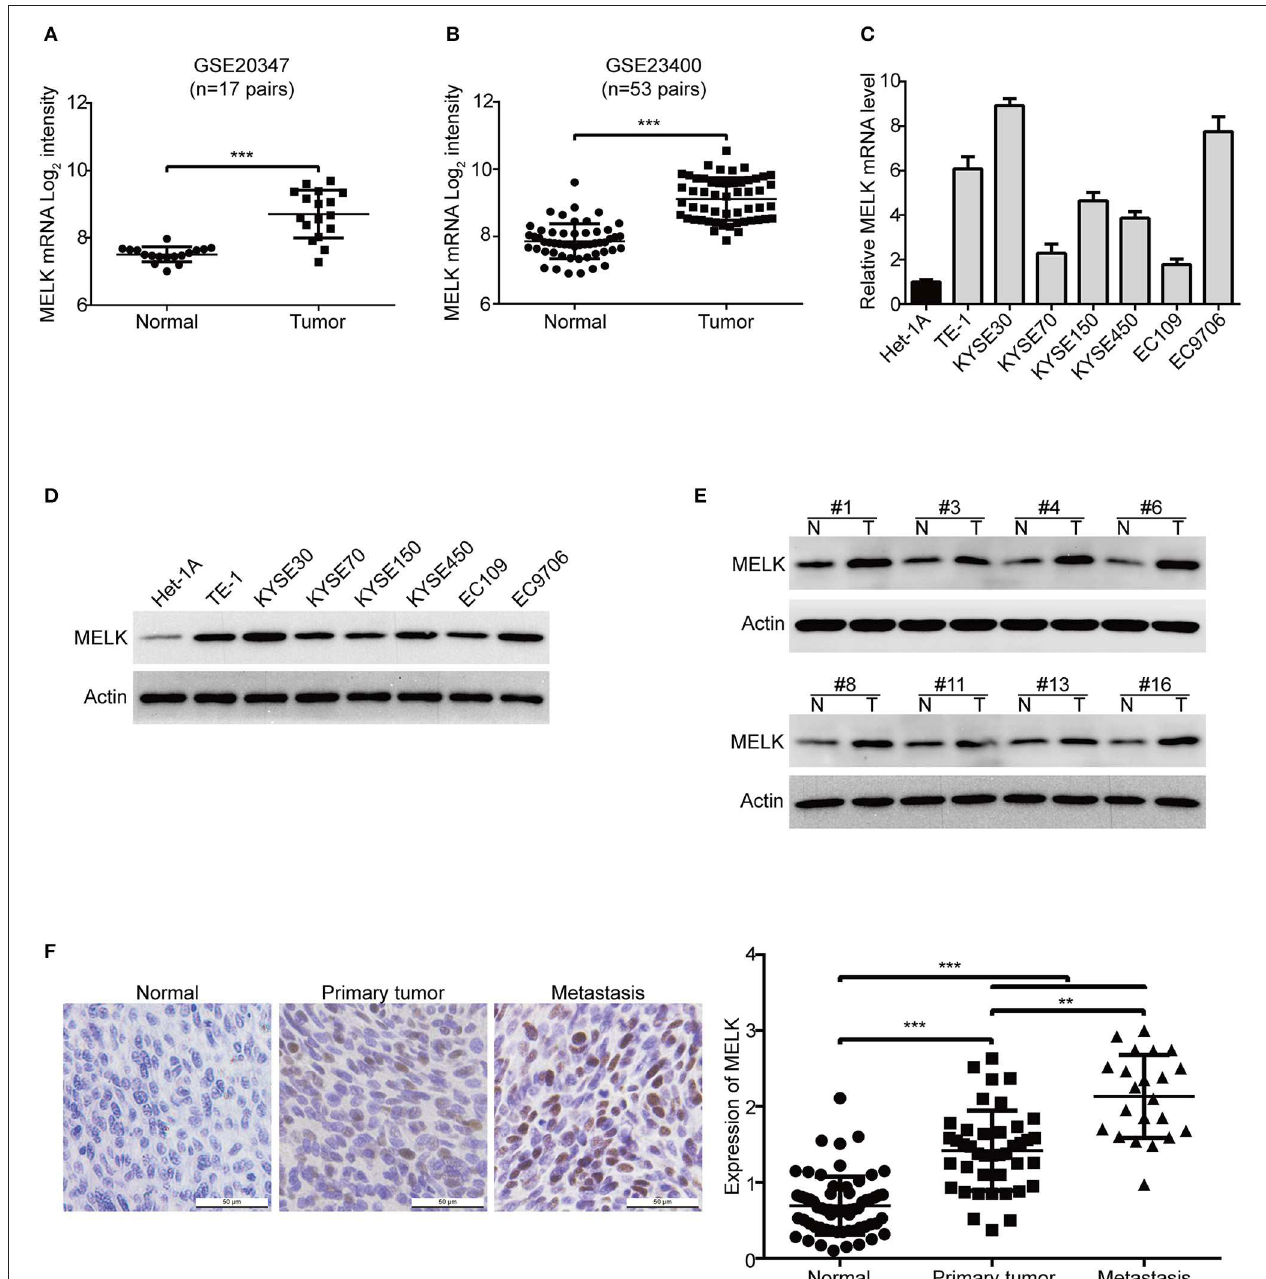
FIGURE 1 | MELK is highly expressed in ESCC. (A,B) MELK mRNA expression was calculated from two Gene Expression Omnibus (GEO) cancer datasets, GSE20347 ( n = 17 pairs) (A) and GSE23400 ( n = 53 pairs) (B) , both of which were examined cDNA microarray from primary ESCC and the corresponding normal tissues. The levels of MELK in one immortalized esophageal epithelial cell line Het-1A and several ESCC cell lines were determined by qRT-PCR (C) and immunoblotting analysis (D) . (E) Western blotting analysis was used to determine MELK expression in 18 pairs of ESCC tumor and matched normal tissues. (F) Representative IHC micrographs (left) and summary bar chart (right) of MELK protein expression in 63 pairs of ESCC tissues (all ESCC cases had paired normal tissues; 41 cases of primary and 22 cases of metastasis). Scale bars, 50 µ m. ** P < 0.01 and *** P < 0.001 by one-way ANOVA, post-hoc intergroup comparisons, Tukey’s